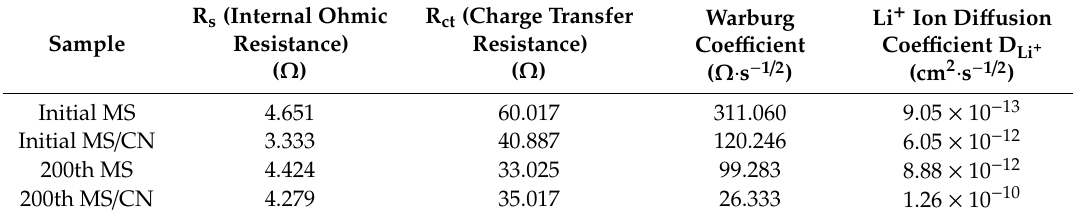
Table 1. Fitted values of the corresponding parameters of the anode electrodes.